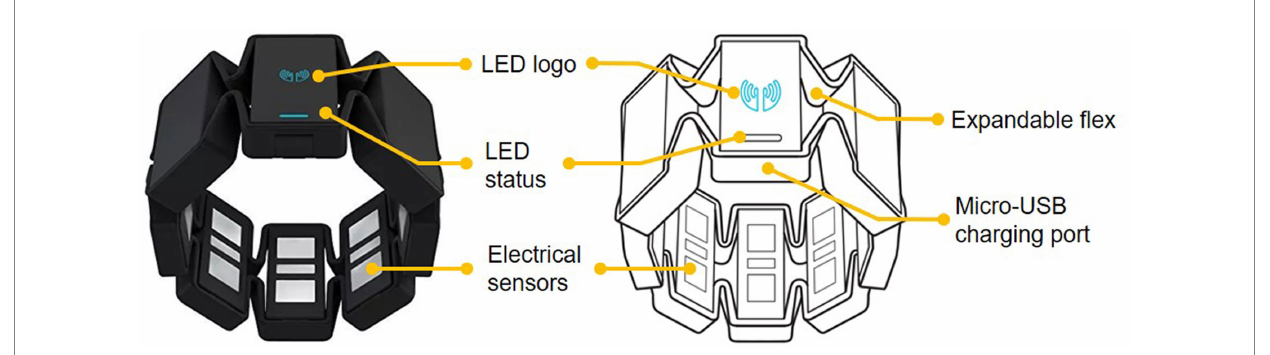
FIGURE 5 The view of Myo armband.